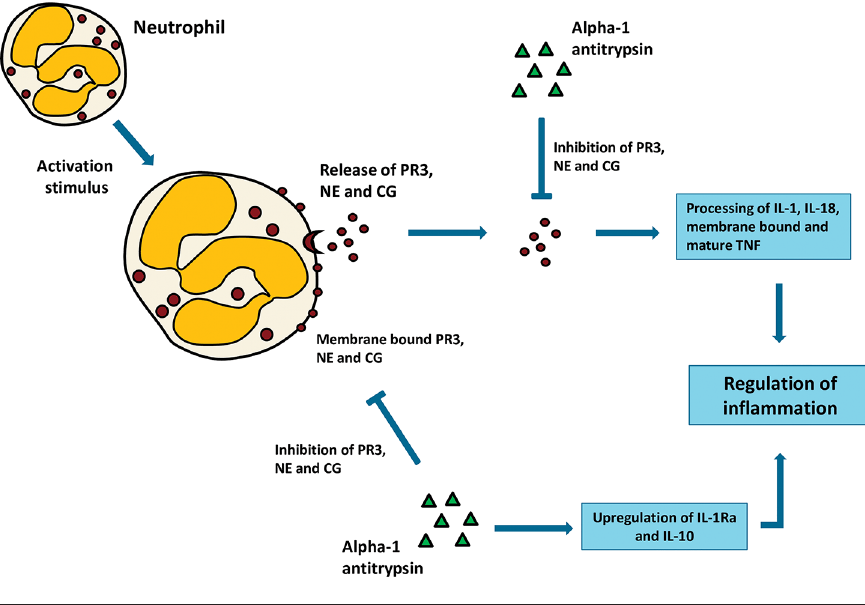
Figure 1. The role of neutrophil serine proteases in inflammation. Following activation, neutrophils will release their serine proteases in the extracellular environment. A portion of these released serine proteases will bind to the membrane. Once released, serine prote- ases (both membrane-bound and in the extracellular environment) are able to process (activate and/or inactivate) cytokines, thereby regulating inflammation. Human α -1 anti- trypsin has potent anti-inflammatory properties. It complexes with proteinase 3,